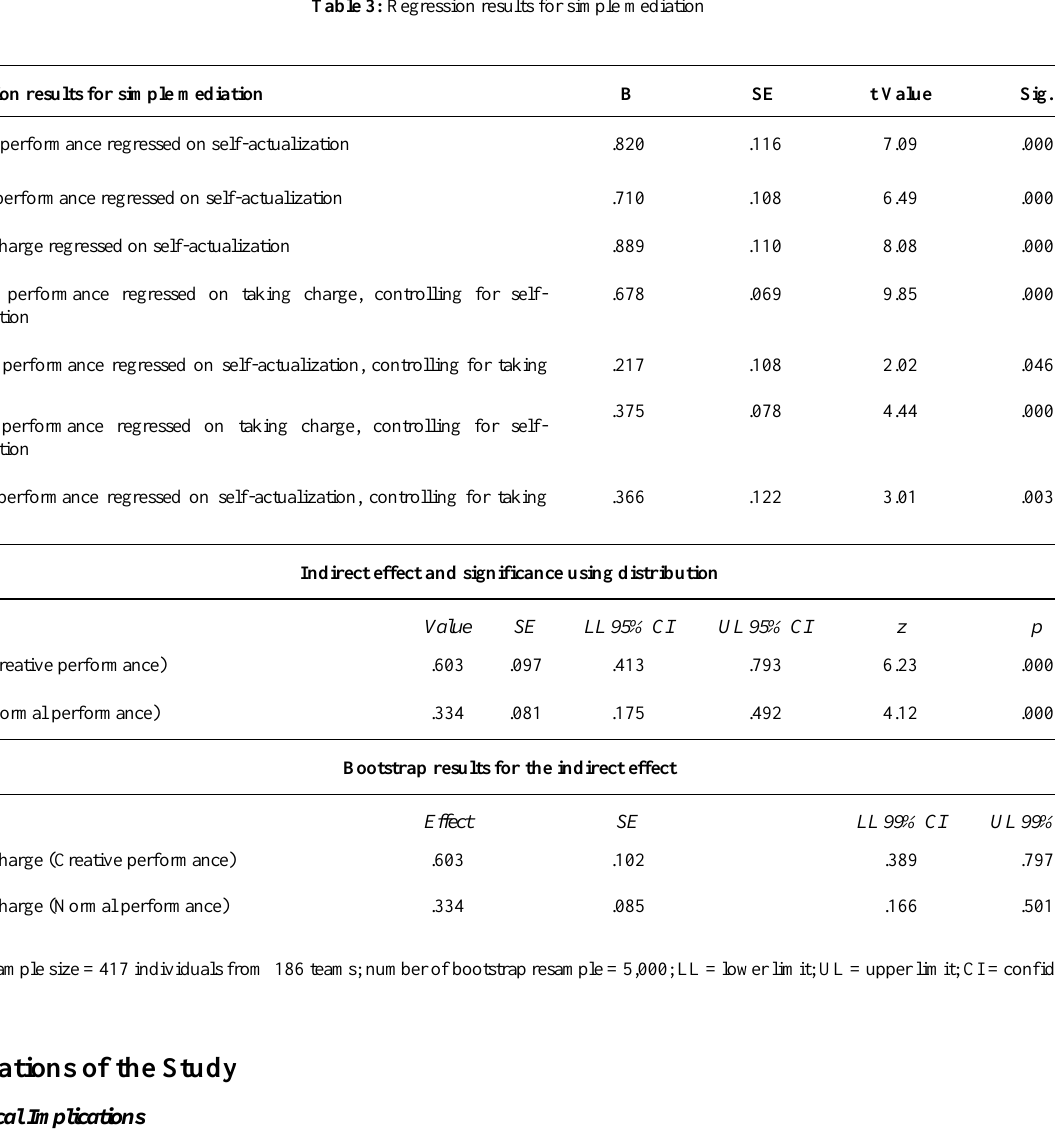
Table 3: Regression results for simple